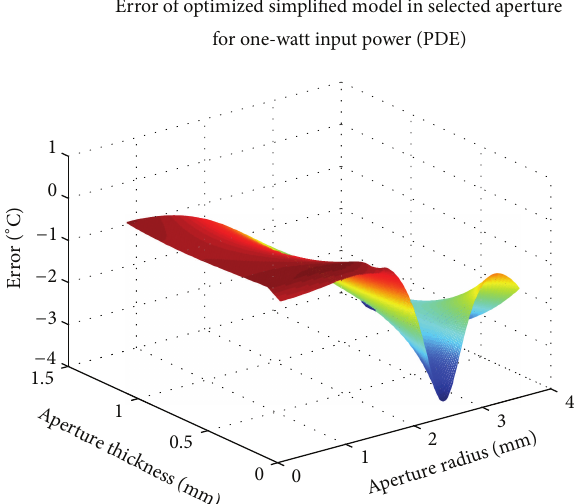
Figure 8: Error distribution in selected aperture after optimization. Obviously, the maximum absolute error within the selected aperture is kept under 3.6 ∘ C. It reaches to its maximum in the area close to the heater. The error in the chamber area is well kept under 0.14 ∘ C.Thechamberareaisarectangularareawith0.9 mmthickness and 1.5mm diameter just on the left bottom corner of the selected aperture.